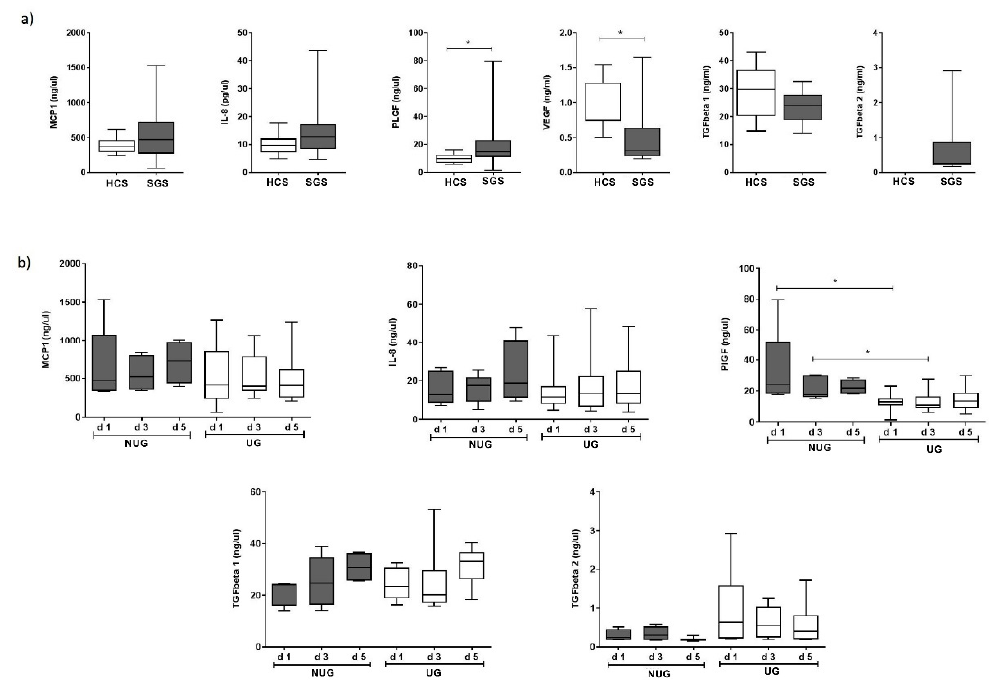
Figure 7. Circulating levels of soluble factors: ( a ) Levels were compared between HCS and 15 patients SGS with a long bone fracture at day 1 post trauma. ( b ) Levels of five factors were compared between patients with a long bone fracture with a union (UG, n = 10) or non-union (NUG, n = 5) outcome at day 1, 3 and 5 after trauma. * Significant difference ( p < 0.05).